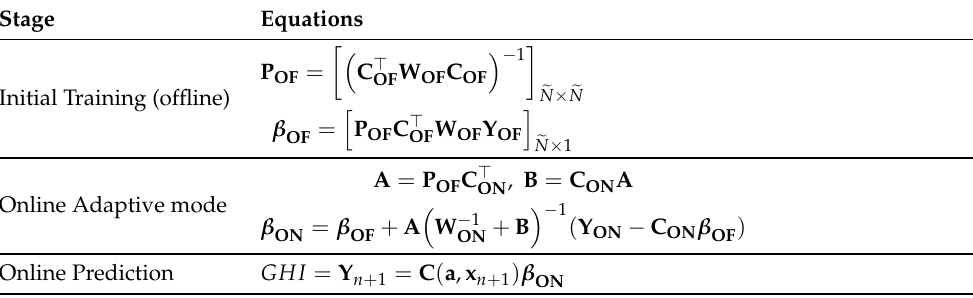
Table 1. Summary of the offline and online computations.